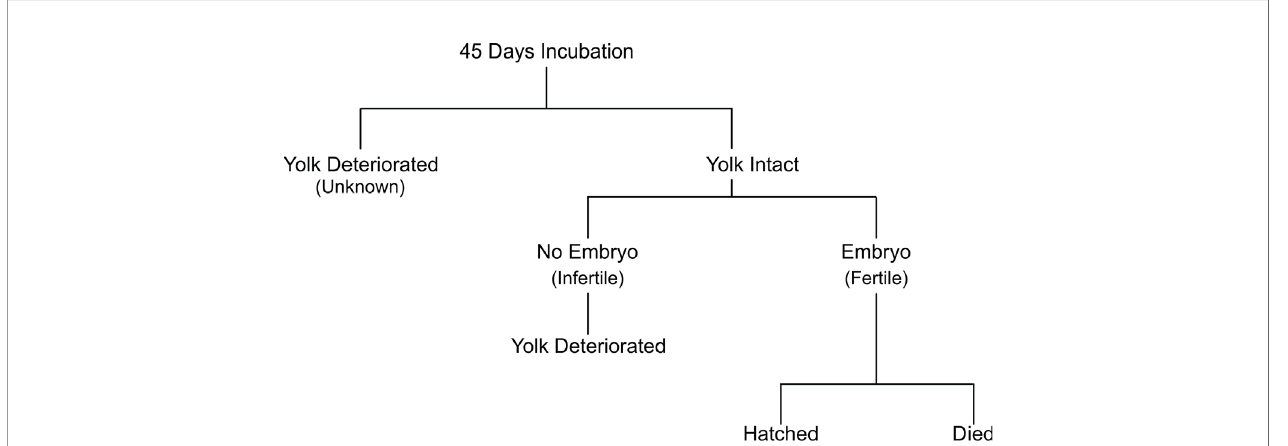
FIGURE 1 | Hierarchy of post-hoc egg fertility assignment and egg